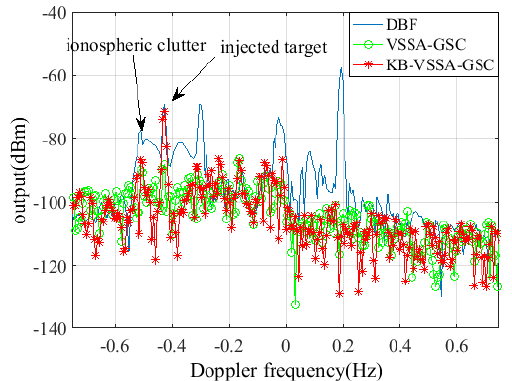
Figure 11. Doppler frequency profile with KB-VSSA-GSC.